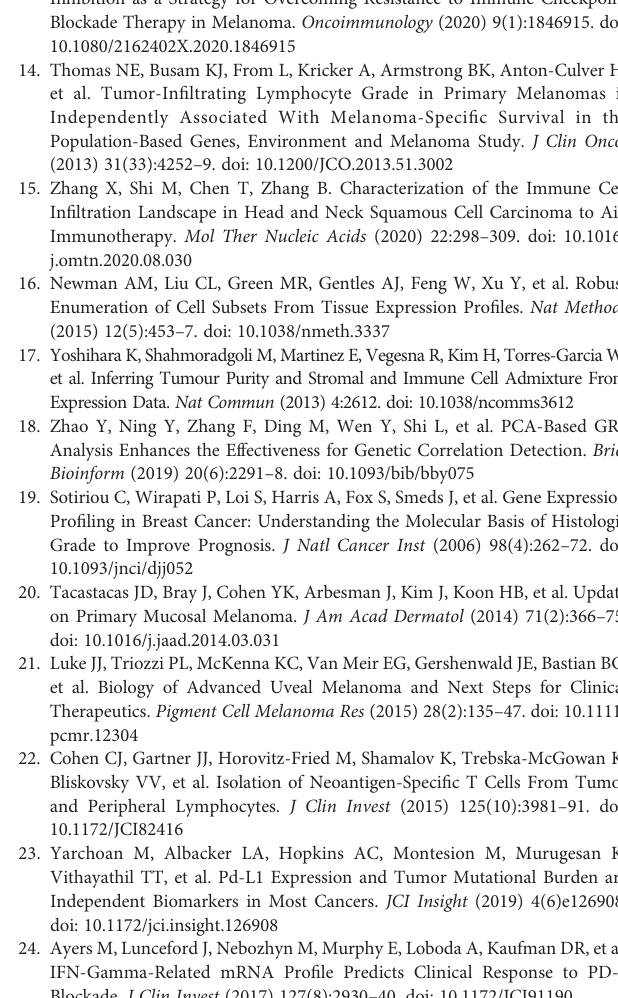
Supplementary Figure 2 | (A – D) Consensus matrixes (K=3-6) of gene cluster for all melanoma sample. (E) The box plot of immune activity related signature genes expression (CXCL9, CXCL10, TNF, IFNG, CD8A, GZMA, GZMB, PRF1) between gene cluster A-C, ****P<0.0001. (F) The box plot of immune checkpoint signature genes expression (CTLA4, PDCD1, PDCD1LG2, LAG3) between gene cluster A-C, ****P<0.0001. Supplementary Figure 3 | Kaplan-Meier curves of overall survival for high and low ICI score cluster in each datasets. (A) , GSE19234; (B) , GSE45617; (C) , GSE54467; (D) , GSE59455; (E) , GSE69504. Supplementary Figure 4 | Systematic Comparision. (A) Kaplan-Meier curve and ROC curve of INF model in GSE19423 cohort. (B) Kaplan-Meier curve and ROC curve of INF model in GSE78220 cohort. (C) Kaplan-Meier curve and ROC curve of INF model in CA209038 cohort. (D) Kaplan-Meier curve and ROC curve of HNSC model in GSE19423 cohort. (E) Kaplan-Meier curve and ROC curve of HNSC modelinGSE78220cohort. (F) Kaplan-MeiercurveandROCcurveofHNSCmodel in CA209038 cohort. (G) Kaplan-Meier curve and ROC curve of ICI score in GSE22154 cohort. Supplementary Figure 5 | The box plot of immune cells fraction in ICI cluster A-C estimated by xCell